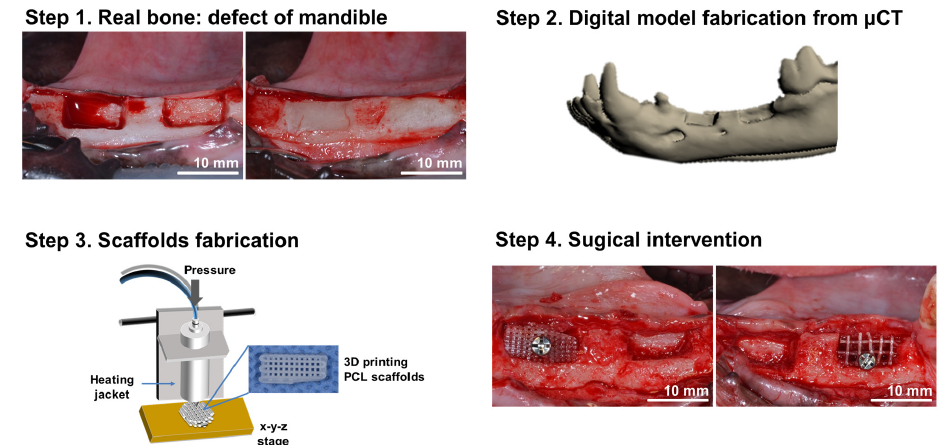
Figure 1. Schematic illustration of the preparation of 3D printed PCL scaffolds for alveolar bone augmentation in a beagle defect model. In the animal, alveolar bone defects were formed and the wax (white) was applied into the defect to maintain the defect volume during the scaffold production. Computed tomography images of the animal were obtained, and a defective mandible model was obtained. The scaffolds were designed using a CAD program and fabricated from PCL using 3D bio-printing techniques. Subsequently, the fabricated scaffolds were implanted into the defects previously formed, and 3 months of healing was allowed.